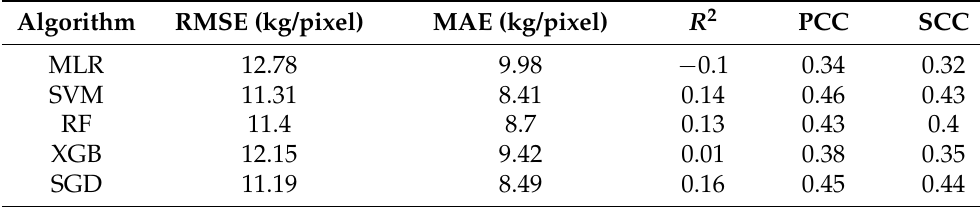
Table 5. Performance of ML models with SMA interpolation method for preprocessing.